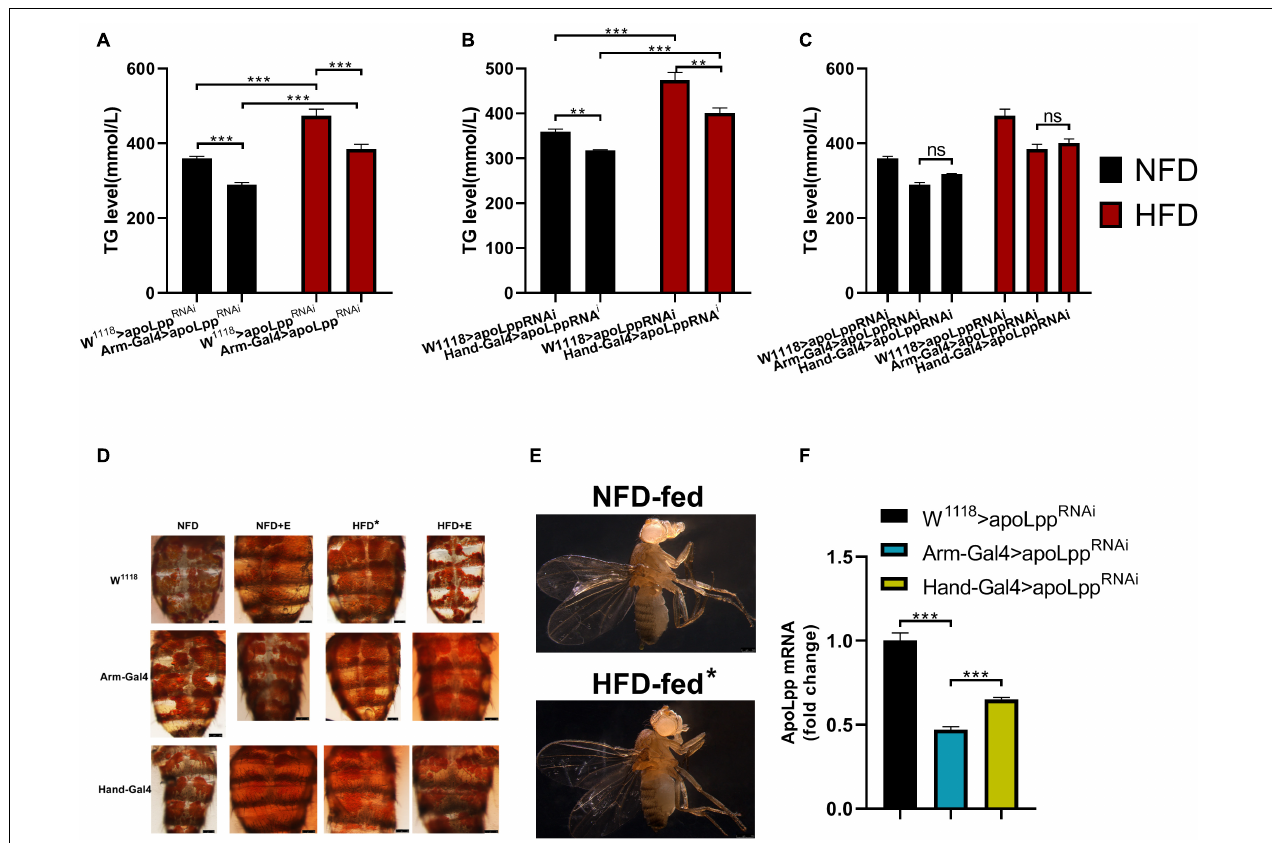
FIGURE 1 | Whole-body triglyceride metabolism in Drosophila . (A) Effect of knockdown of whole-body apoLpp on whole-body TG levels under different dietary conditions. (B) Effect of specific knockdown of cardiac apoLpp on whole-body TG levels under different dietary conditions. (C) Differential effects of whole-body apoLpp knockdown vs. apoLpp cardiac-specific knockdown. (D) Drosophila abdominal ORO staining. (E) Lateral morphological photographs of Drosophila . When fed with HFD, the abdomen of Drosophila was significantly bulging and large in size. (F) The relative expression of apoLpp under normal dietary conditions with different knockdown effects. arm-Gal4 knockdown efficiency was 53%, while Hand-Gal4 knockdown efficiency was 35%. All samples were females. The whole-body triglyceride sample size was 15 and apoLpp mRNA sample volume of 60 hearts or 10 whole-body. Figures (A,B) use two-way ANOVA, and figures (C,F) use independent samples t -tests. * P < 0.05, ** P < 0.01, *** P <